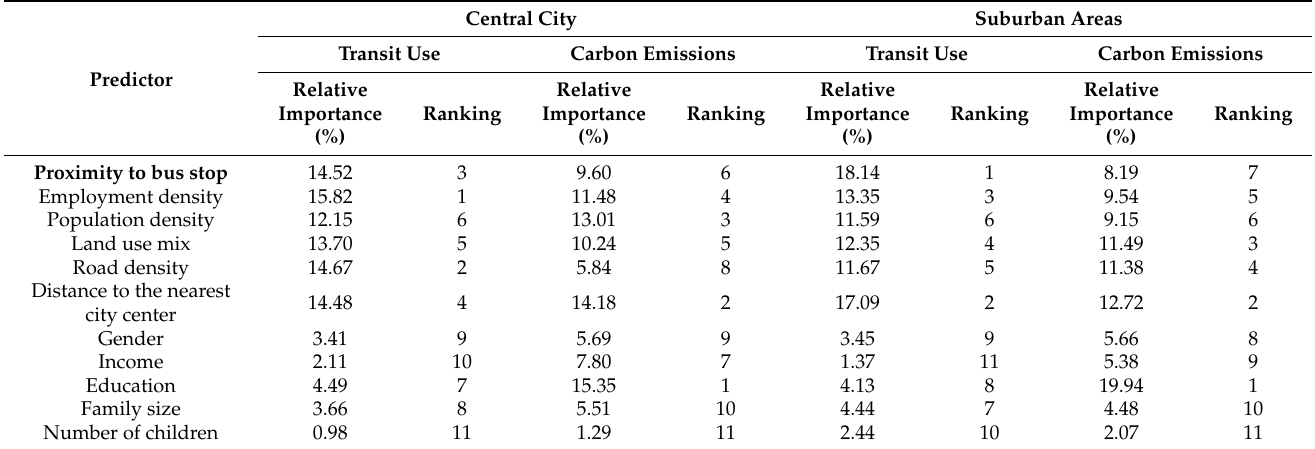
Table 4. Relative importance of independent variables on transit use and carbon